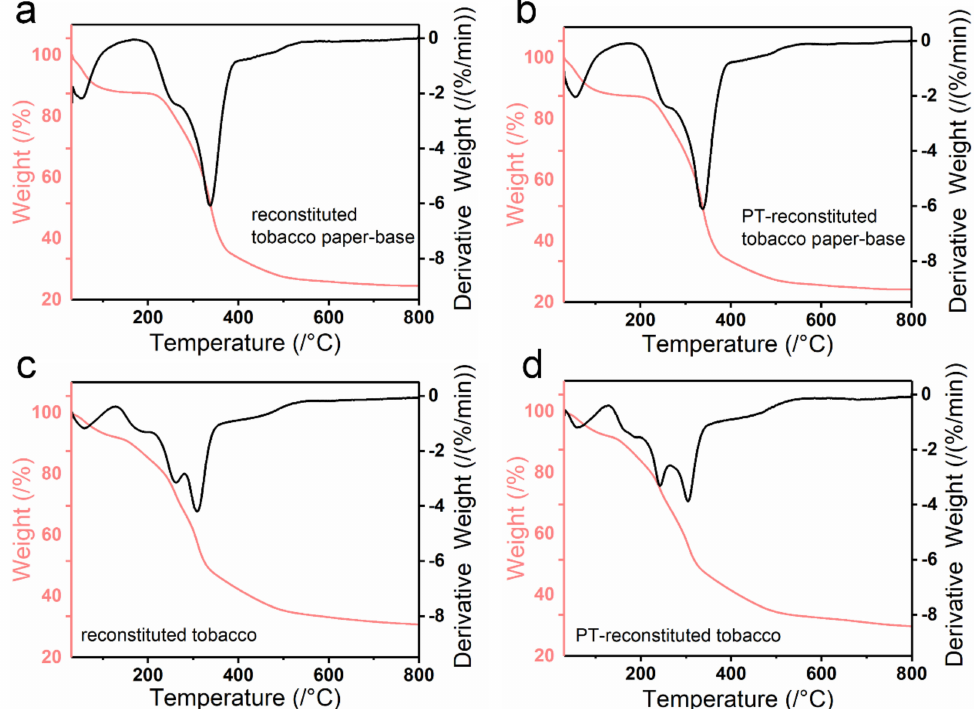
Figure 8. Thermogravimetric analysis (TGA) curves of ( a ) reconstituted tobacco paper-base, ( b ) PT-reconstituted tobacco paper-base, ( c ) reconstituted tobacco, and ( d ) PT-reconstituted